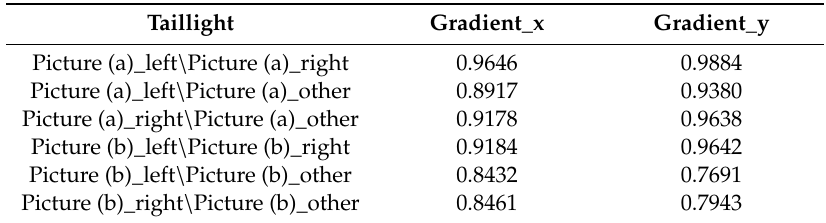
Table 5. Correlation coefficient for the taillight candidate regions.